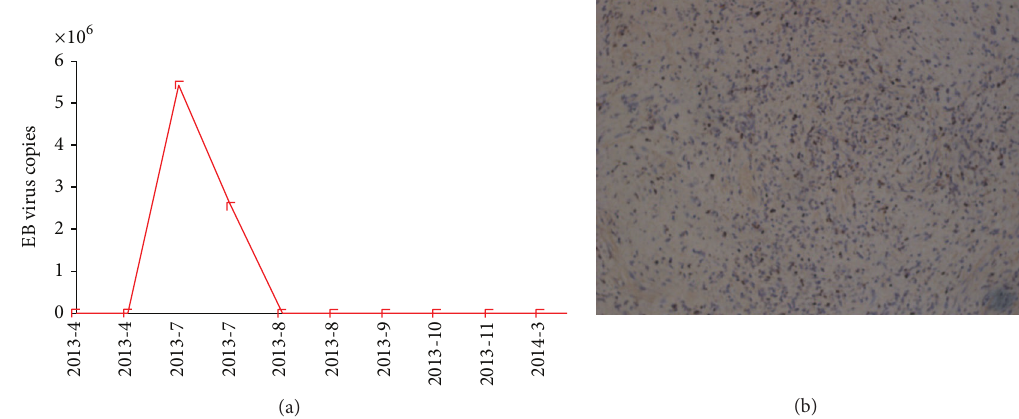
Figure 3: Epstein-Barr virus infection. (a) Detection of the Epstein-Barr virus by PCR. EBV copies were shown from 2013.4 to 2014.3. (b) The biopsy of EBV.